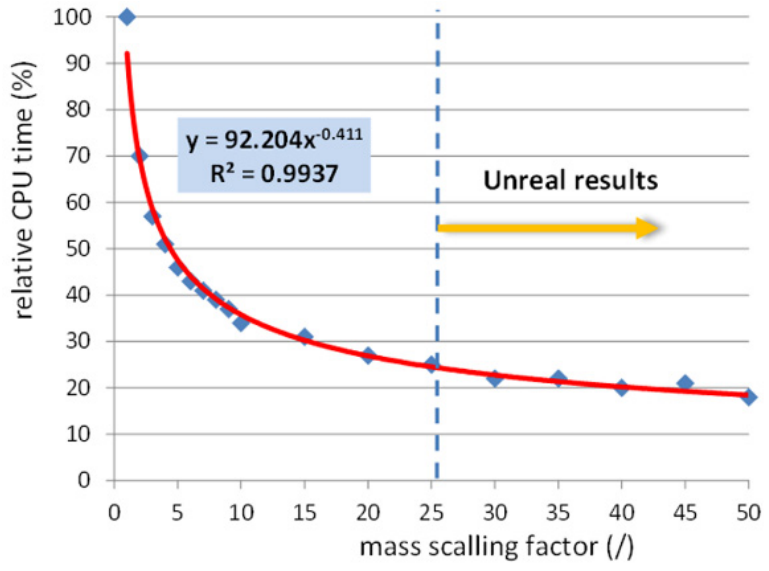
Figure 7. Effects on CPU time by mass scaling of the SPIF process at a punch speed of 40 m/s and element size of 3 × 3 mm.